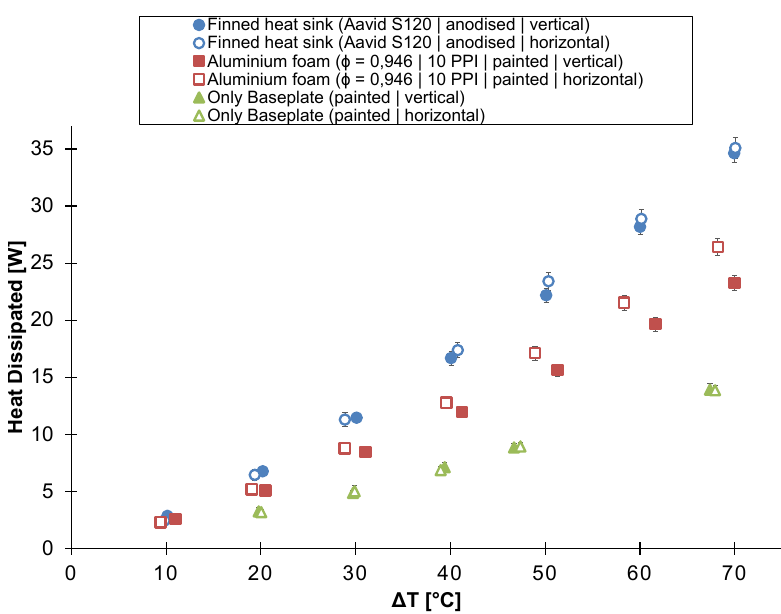
Figure 11. The heat dissipated by the heat sink at different orientations as a function of the temperature difference between the ambient air and the heat sink’s base plate (heat sink’s height = 22 mm; the 4”-side is parallel with the gravity in the vertical